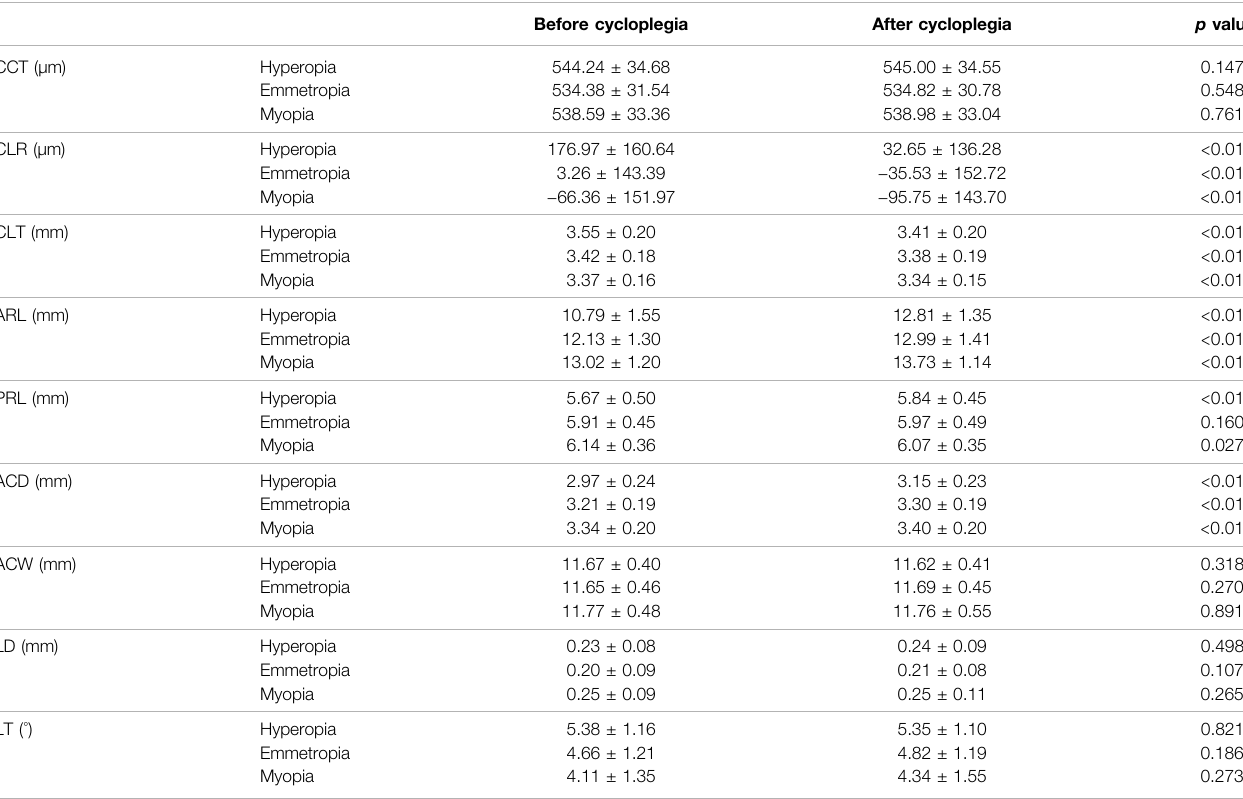
TABLE 2 | Anterior segment parameters before and after cycloplegia.